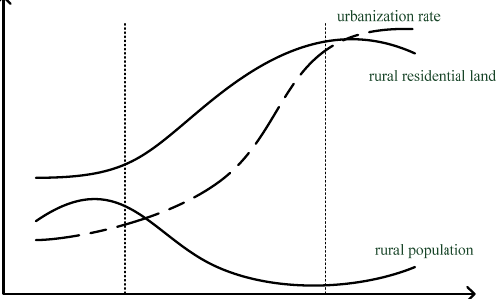
Figure 1 . Rural population and land use at different urbanization stages. Figure 1. Rural population and land use at different urbanization